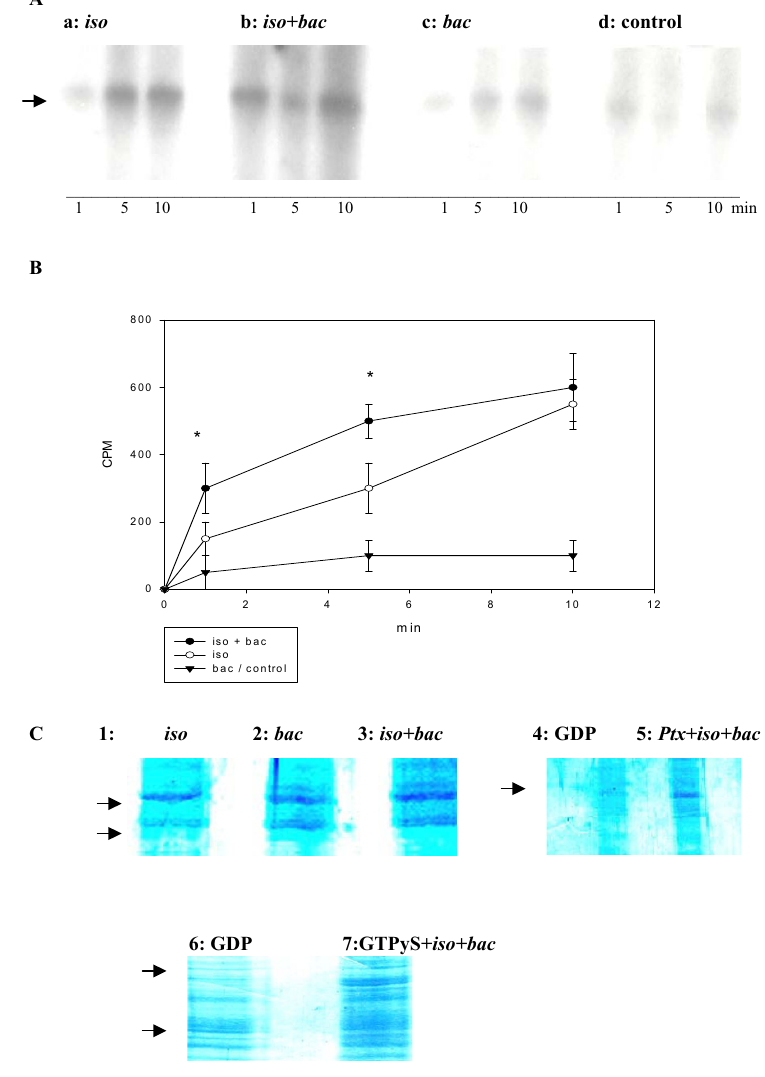
B: Quantification of ADP ribosylated Gás in Forskolin agarose 'pull down' Same experiment as in A except that